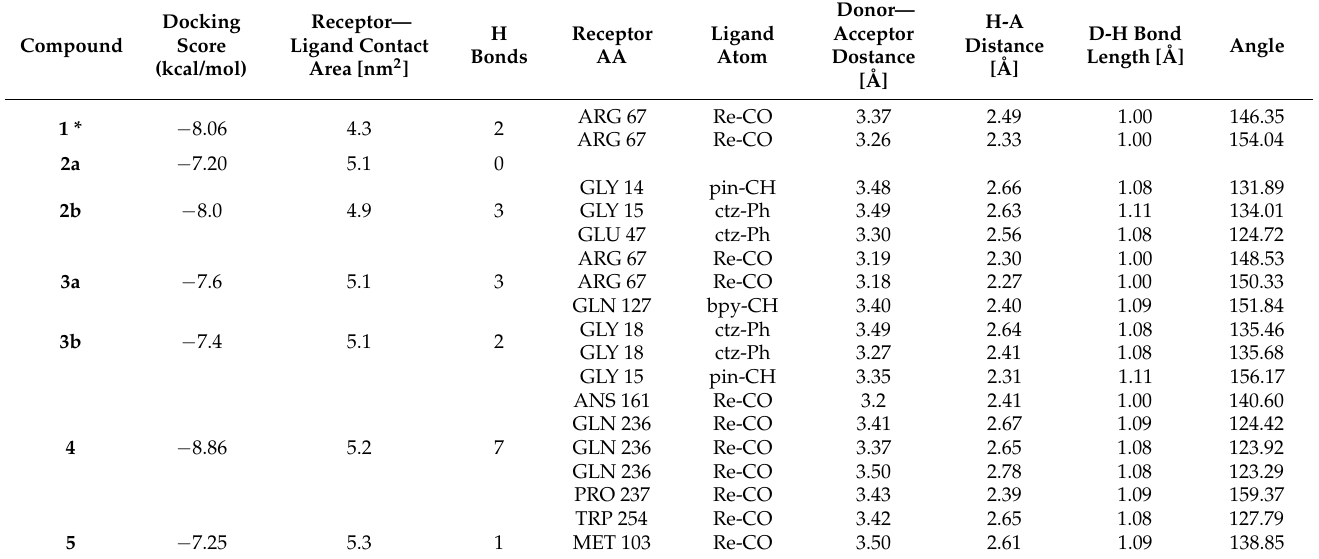
Table 2. Molecular docking results for the homological model MurG inhibitors 1 – 5 .